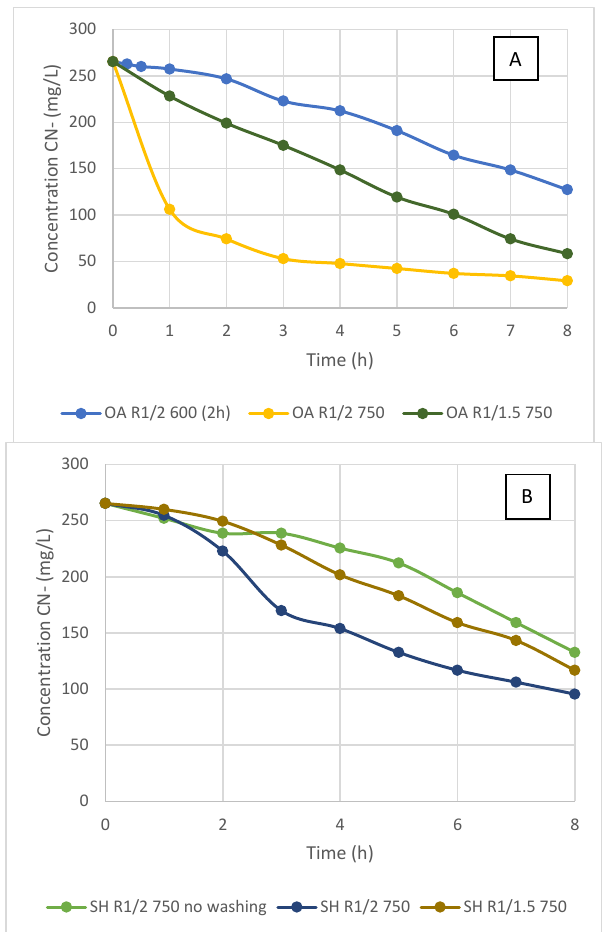
Fig. 5: Evaluation of the molar Ni/Fe ratio of ferrites prepared in the oxidation of cyanide ion (15 g/L, 180 NL/h, 5.5-8.5 mg O 2 /L, 800 rpm). (a) Hydro-chemical pathway with oxalic acid (OA). (b) Co-precipitation pathway with sodium hydroxide (SH)